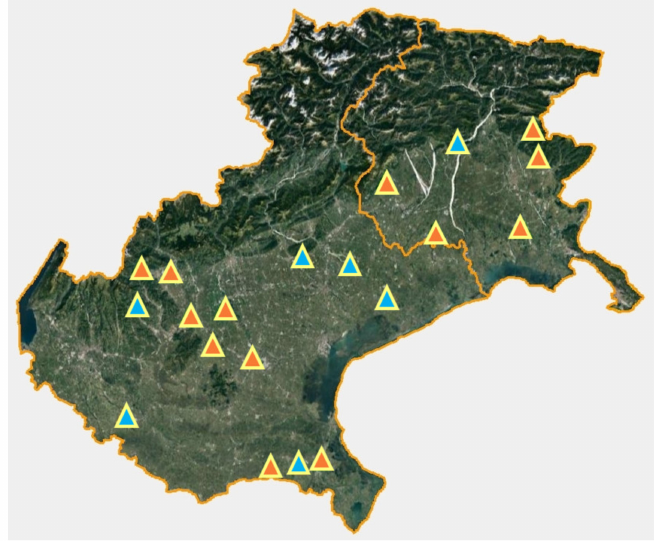
Figure 1. Location of the studied farms in the two regions of Veneto (on the left) and Friuli-Venezia Giulia (on the right). Farms exclusively surveyed through questionnaire (n = 7) are marked in blue, while orange designates those also sampled for coprological analysis (n =